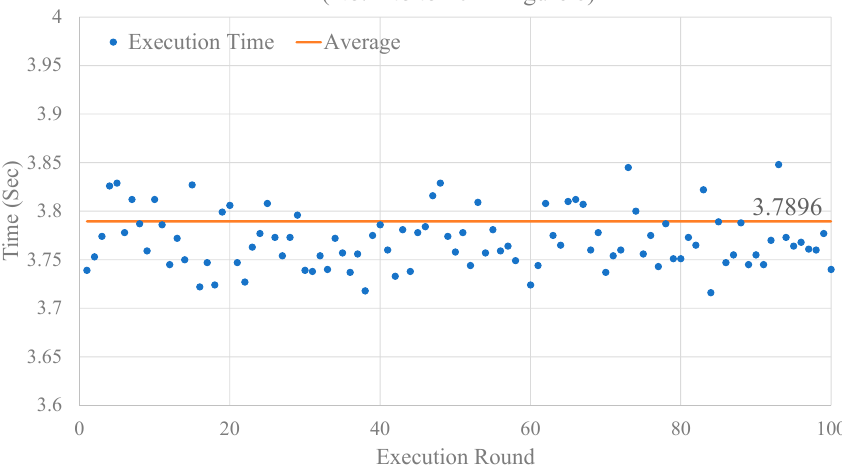
Figure 11. Data contribution processing time in each round for the Hyperledger Fabric part.